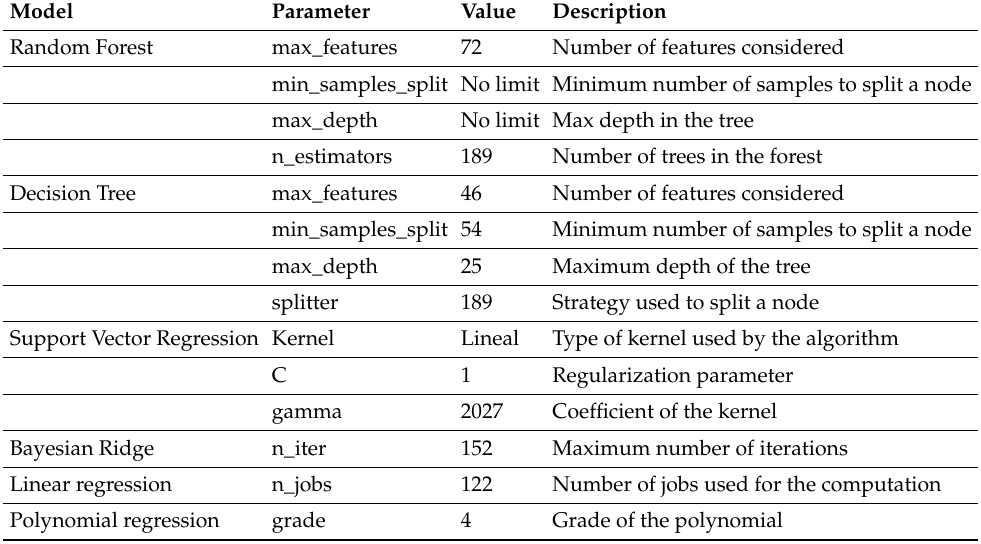
Table 3. List of the optimal values for the automatically selected parameters for each implemented machine learning (ML)